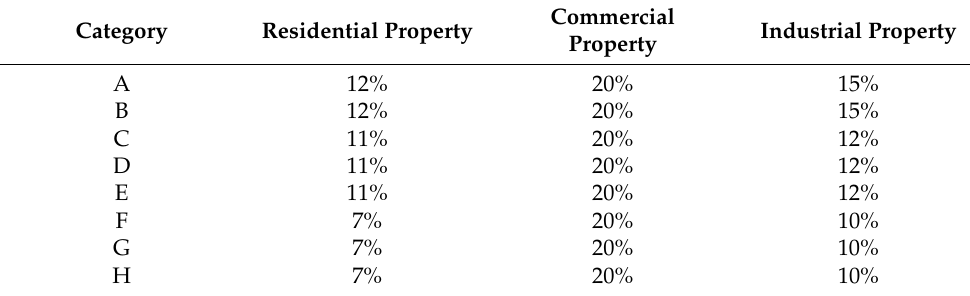
Table 3. Rate of Colony Categories for Property Tax Calculation. Category Residential Property